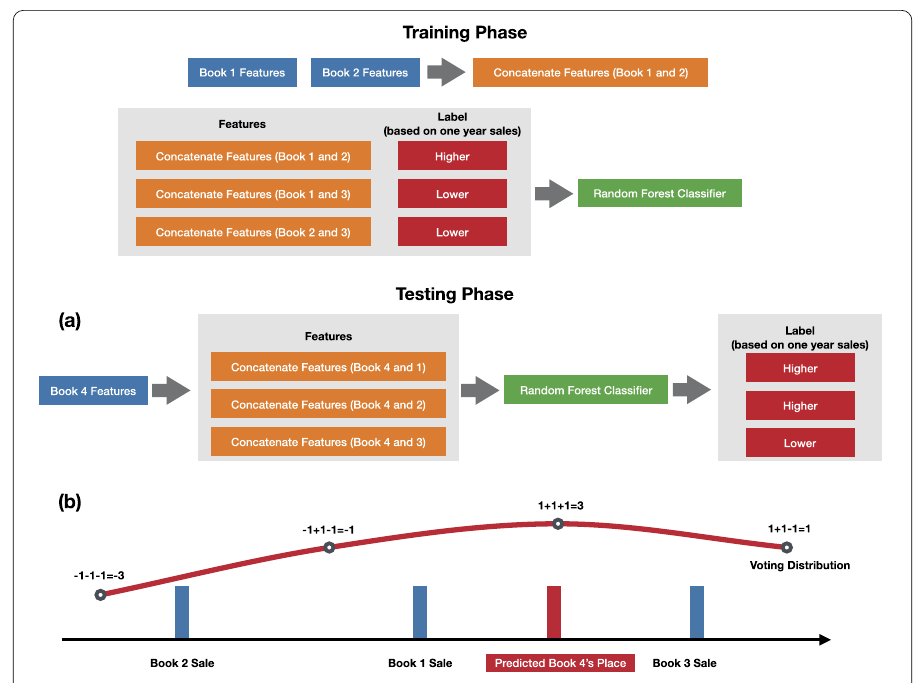
Figure 6 LearningtoPlace flowchart explanation. Training Phase: create pairwise feature concatenation for all book pairs in training set and train the Random Forest Classifier on the pairwise preferences. Testing Phase: ( a ) Predict pairwise preferences between new book and all book in the training set using the trained Random Forest Classifier. ( b ) Place new book in the given sequence of books from the training set ranked by sales. To obtain predicted sale for the new book, we simply take the highest voted interval and take the average of this interval as the predicted sale for the new